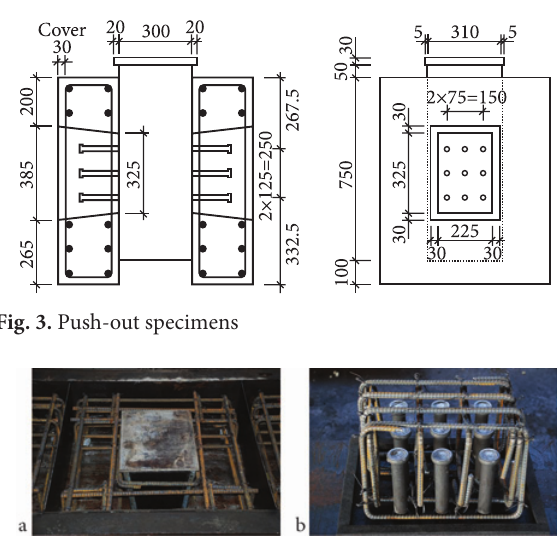
Fig. 4. Details of confining reinforcement: a – external reinforcements; b – internal reinforcement 16 mm reinforcing bars are placed at the top and bottom concrete slab. The slab has 400 mm thickness and the de- sign compressive strength of concrete is 40 MPa. Average